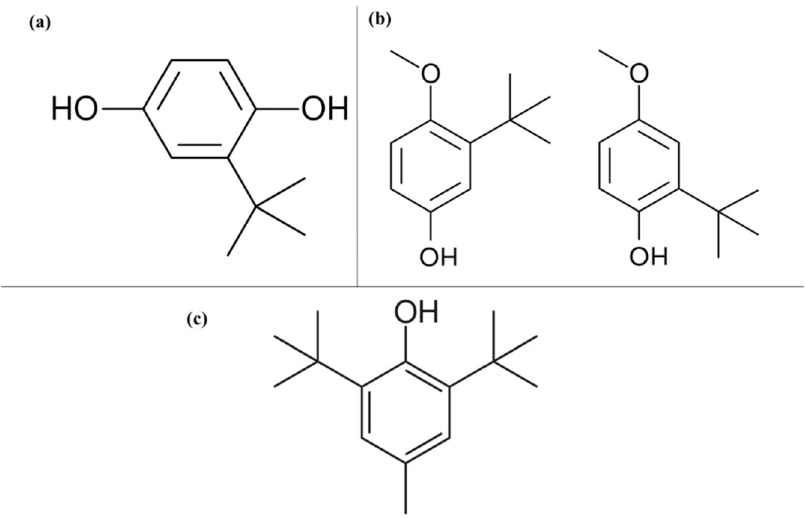
Figure 4. Chemical structures of the molecules. ( a ) Tert-butyl hydroquinone (TBHQ); ( b ) Butyl hydroxyanisole (BHA); ( c ) Butylated hydroxytoluene (BHT).